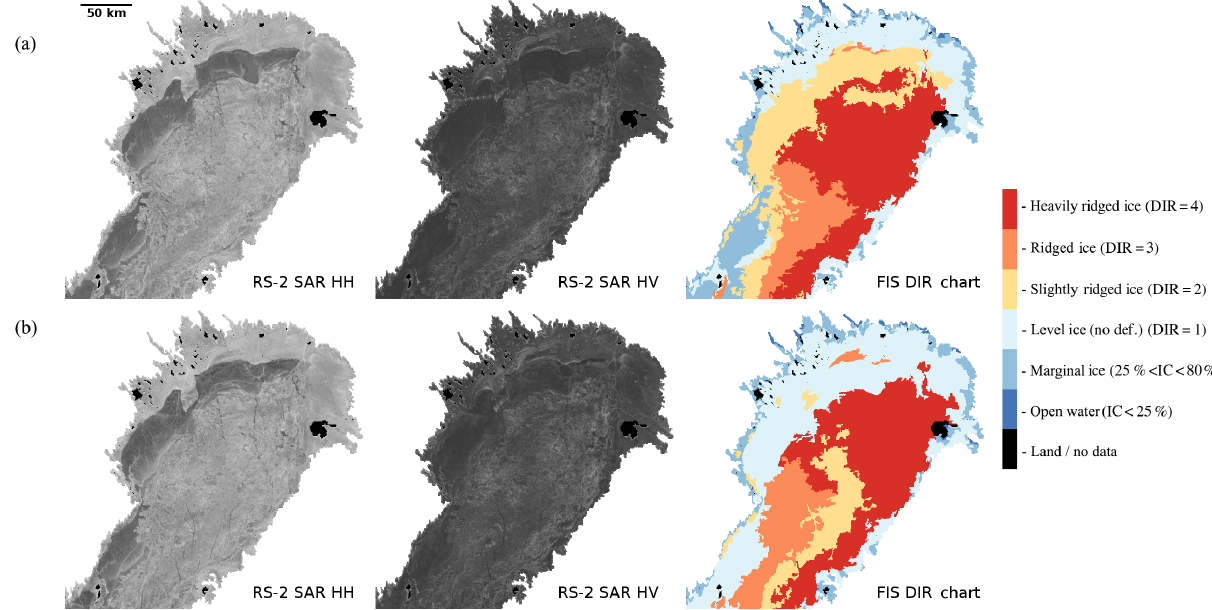
Figure 3. Example of RS-2 SAR data mosaic in HH and HV polarization and the corresponding DIR chart with values extracted from the digitized Finnish ice charts for 9 March 2013 in the upper panel and 12 March in the lower panel. On both days the SAR shows a similar ice situation, although the two DIR charts show changes in the ridging classes: in the NW of the Bay of Bothnia, from slightly ridged ice (DIR 2) to level ice (DIR 1), and in the central to southern part of the Bay of Bothnia, from heavily ridged ice (DIR 4) to slightly ridged ice (DIR 2). In this case, the data from 9 March 2013 were removed from the